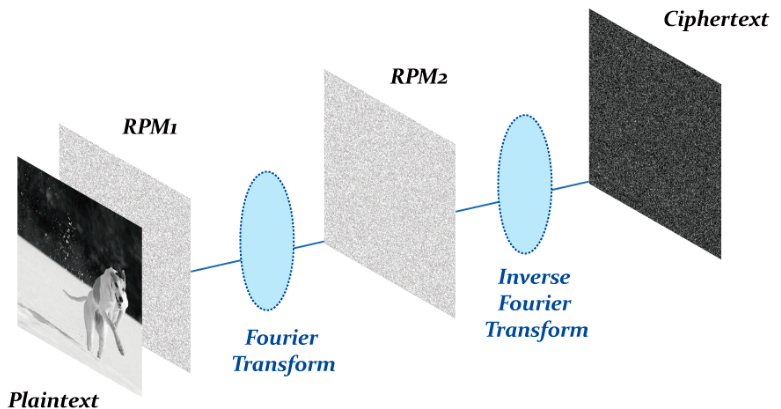
Figure 1. Encryption process of DRPE.